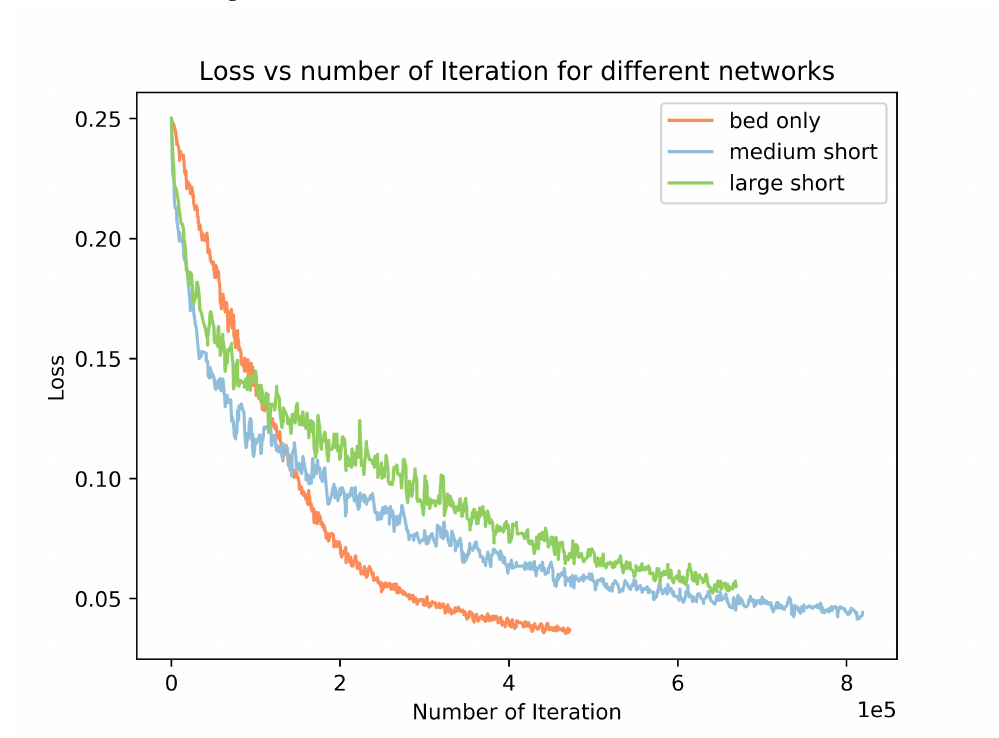
Figure 17. Segmentation training loss for different scale